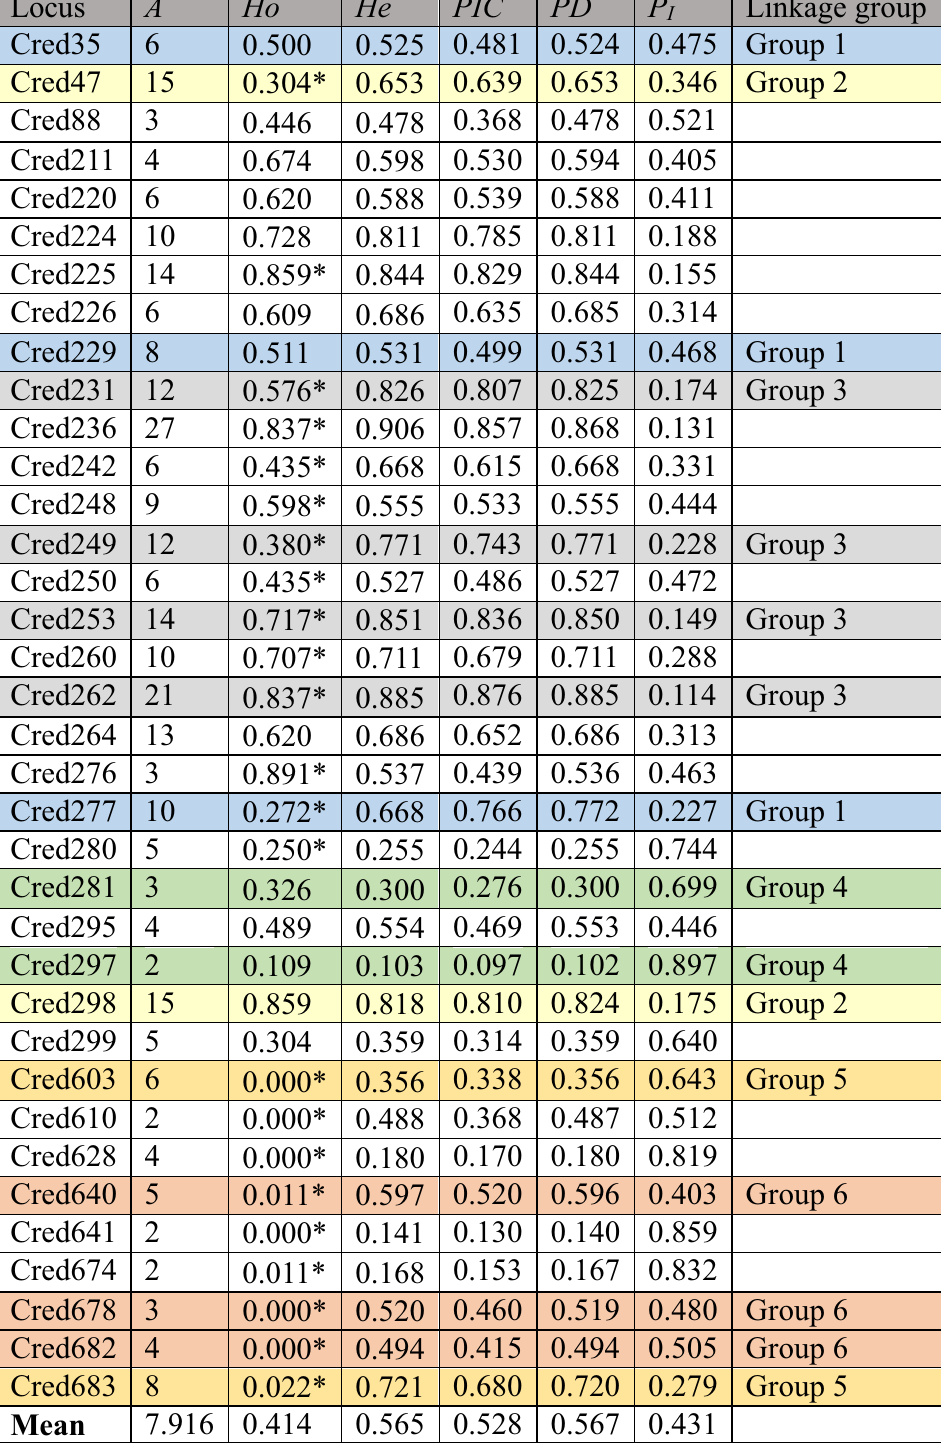
Table 2. Genetic characterization of 36 polymorphic SSR loci of 92 Chamaecyparis formosensis individuals. A: number of alleles, Ho: observed heterozygosity, He: expected heterozygosity, PIC: polymorphism information content or power of information content, PD: power of discrimination, P I : the probability of identity, PD is equal to 1 –